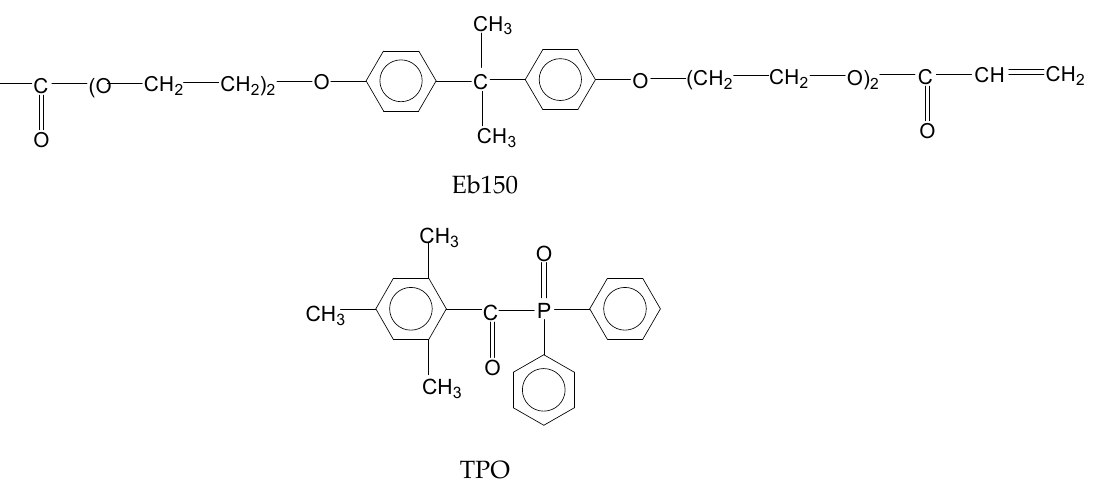
Figure 1. Chemical structures of Eb150 and TPO.